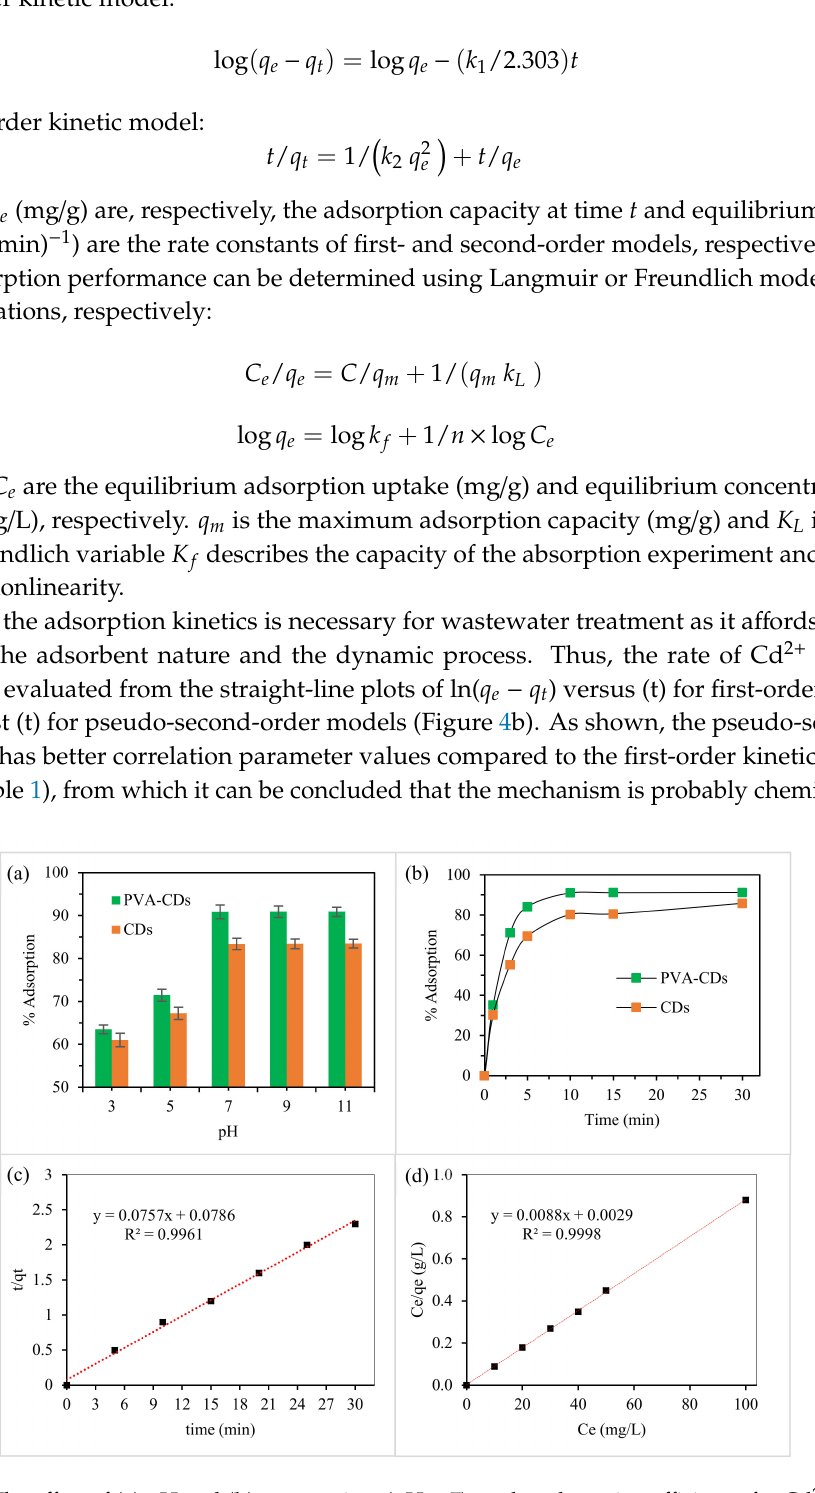
Figure 5. The e ff ect of ( a ) pH and ( b ) contact time (pH = 7) on the adsorption e ffi ciency for Cd 2 + using CDs and PVA-CDs, ( c ) Pseudo-second-order model for adsorption Cd 2 + onto PVA-CDs, ( d ) linearity graph of Langmuir